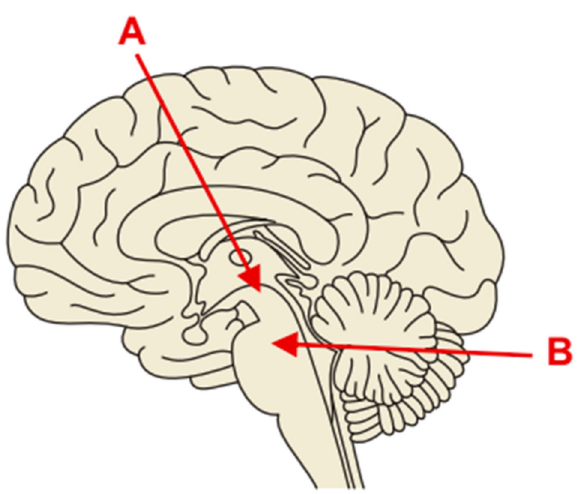
Figure 1. Scheme of the approaches of stereotactic biopsy. ( A ) The biopsy trajectory of the tumor located around the cerebral peduncles (supratentorial approach). ( B ) The biopsy trajectory of the brainstem tumors below the level of the peduncles (infratentorial